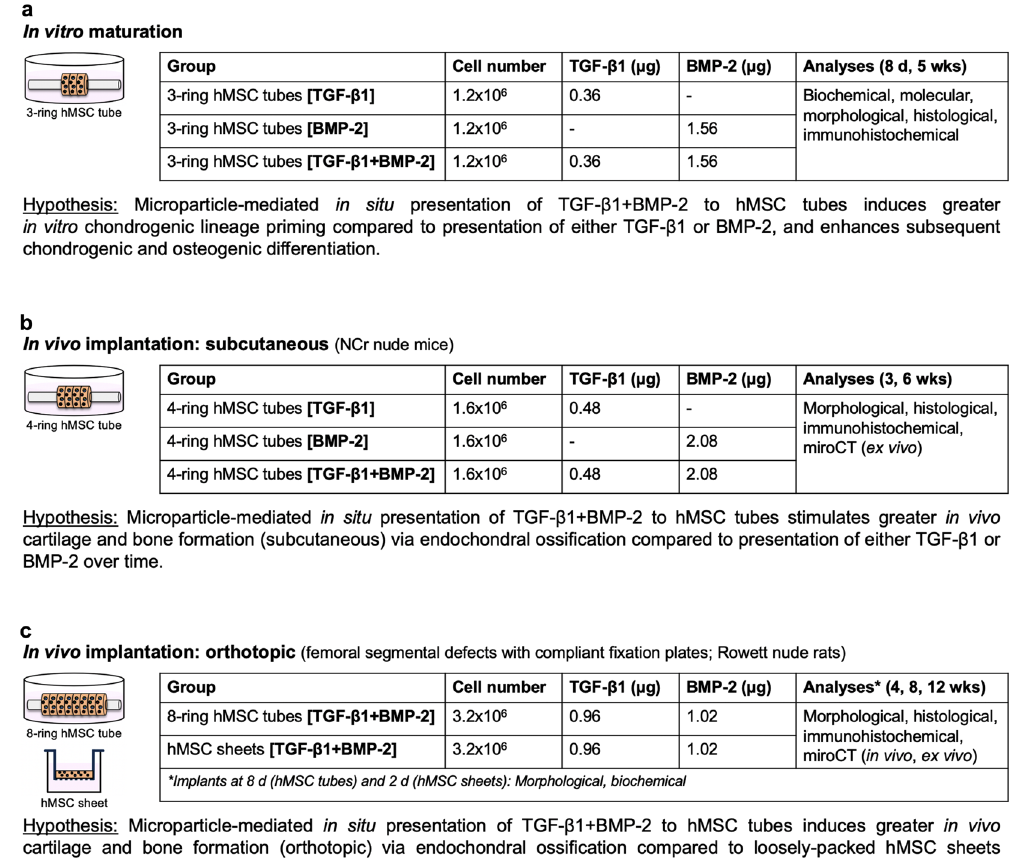
Fig. 1 Study design and hypotheses. a In vitro maturation, b in vivo implantation (subcutaneous), and c in vivo implantation (orthotopic) of hMSC tubes containing morphogen-loaded